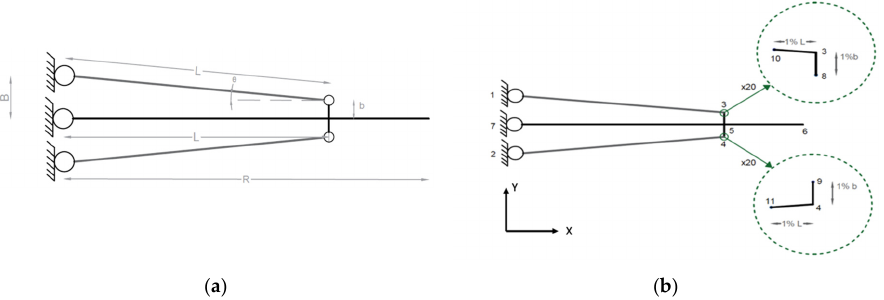
Figure 3. Finite element model of the actuator. ( a ) Simplified actuator scheme; ( b ) Mesh of the actuator. Each finite element of the mesh was a beam and had three degrees of freedom for each node that could be collected in the vector (cid:2012) (cid:3021) = (cid:4670)(cid:2012) (cid:3036)(cid:3051) (cid:2012) (cid:3036)(cid:3052) (cid:2030) (cid:3036) (cid:2012) (cid:3037)(cid:3051) (cid:2012) (cid:3037)(cid:3052) (cid:2030) (cid:3037) (cid:4671) , with (cid:1861) and (cid:1862) being the nodes of the beam while x and y are the local reference system variables along, and normal to, the beam axis oriented from i to j . The element stiffness matrix was the one computed from the Euler–Bernoulli beam. The stacks’ equivalent nodal force vector was obtained, extending the one computed for the piezoelectric rod: